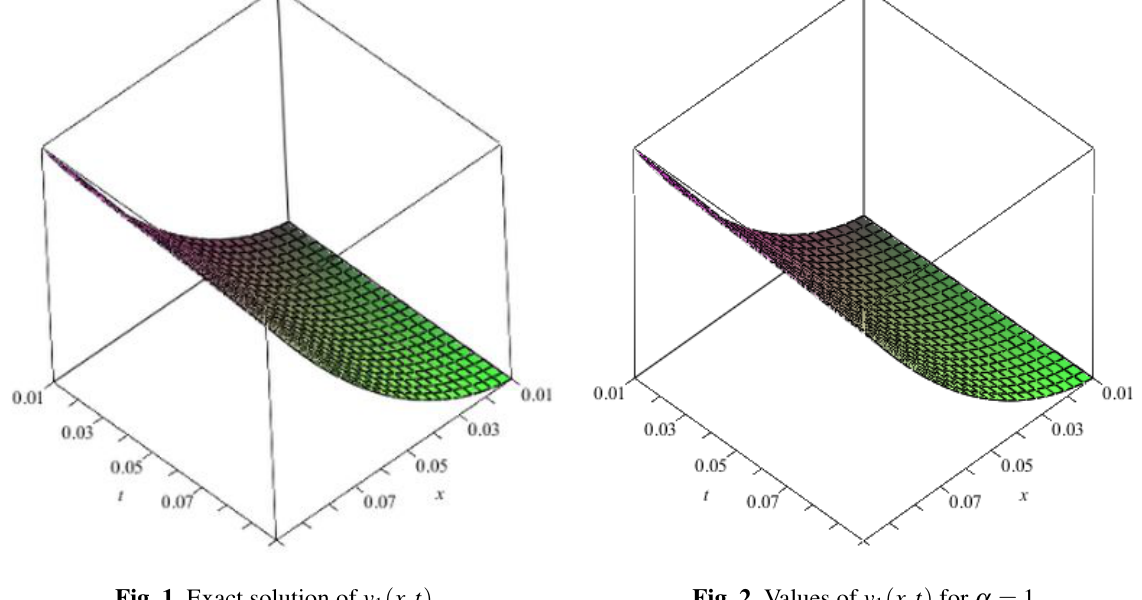
Fig. 1 Exact solution of v 1 ( x , t ) . Fig. 2 Values of v 1 ( x , t ) for α = 1.